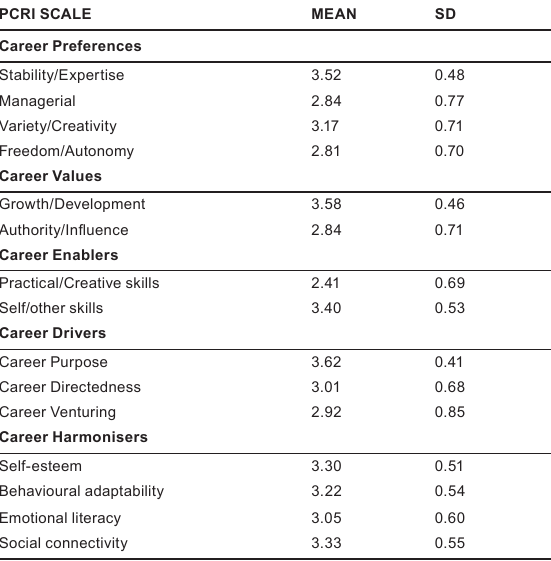
Table 2 Descriptive statistics: PCRI scales (N = 2 997)